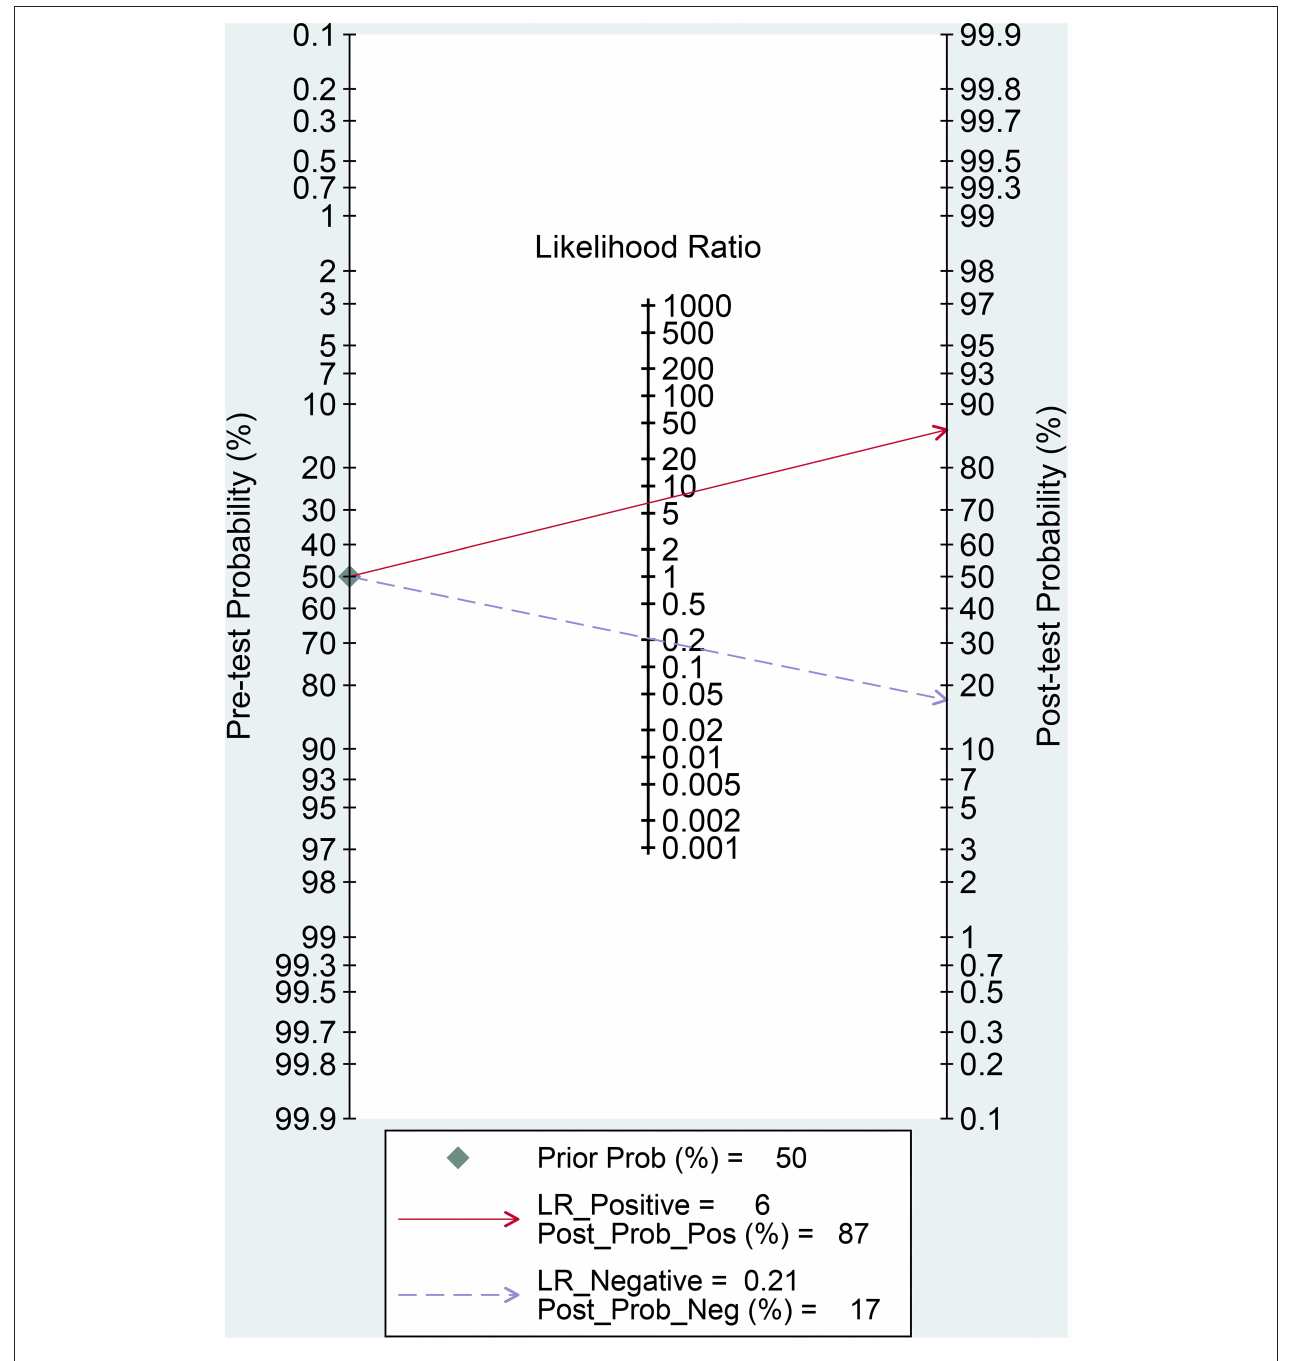
FIGURE 4 | Fagan’s nomogram for evaluating the post-test